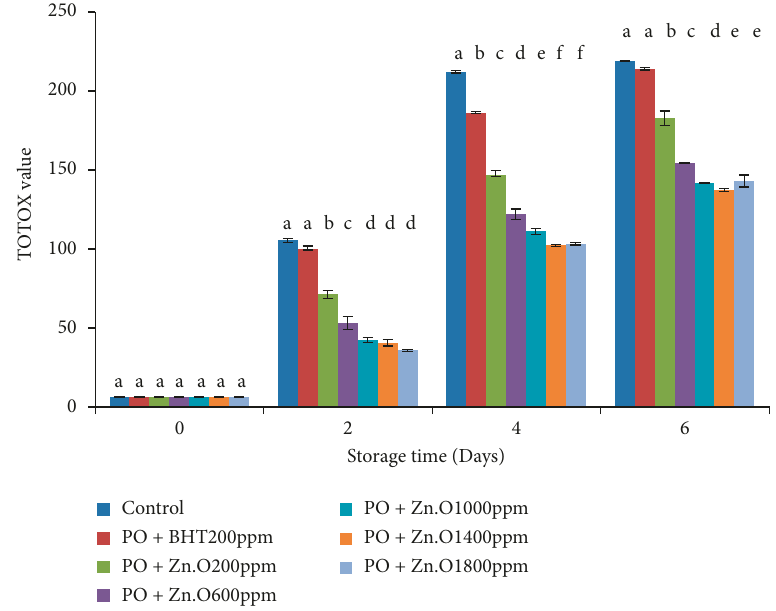
Figure 3: Variations in TOTOX value of palm olein enriched with different concentrations of ginger extract during storage at frying temperature. BHT: butylated hydroxytoluene; PO: palm olein; Zn.O: Zingiber officinale (ginger); control: palm olein without antioxidant; PO+BHT 200 ppm : palm olein+ 200ppm BHT; PO +Zn.O 200ppm : palm olein+200ppm ginger root extract; PO +Zn.O 600ppm : palm olein+600ppm ginger root extract; PO+Zn.O 1000ppm : palm olein+1000ppm ginger root extract; PO+Zn.O 1400ppm : palm olein+1400ppm ginger root extract; PO +Zn.O 1800ppm : palm olein+1800ppm ginger root extract. Data are presented as mean ± standard deviation ( n � 3). a–d values of the same storage day with different superscripts differ significantly at p < 0 .